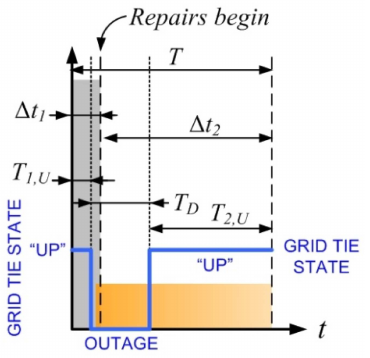
Figure 2. Relevant time intervals for the first two phases of an extreme